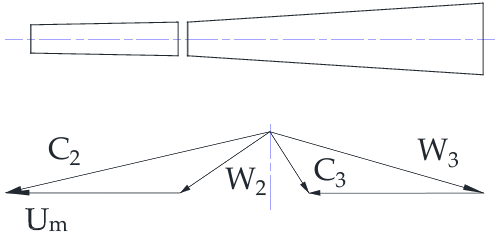
Figure 8. The turbine section channel and relative velocity triangles at π e = 10 and 10kg · s − 1 . The degree of reaction is 0.2 and the rotational speed is fixed to 3000